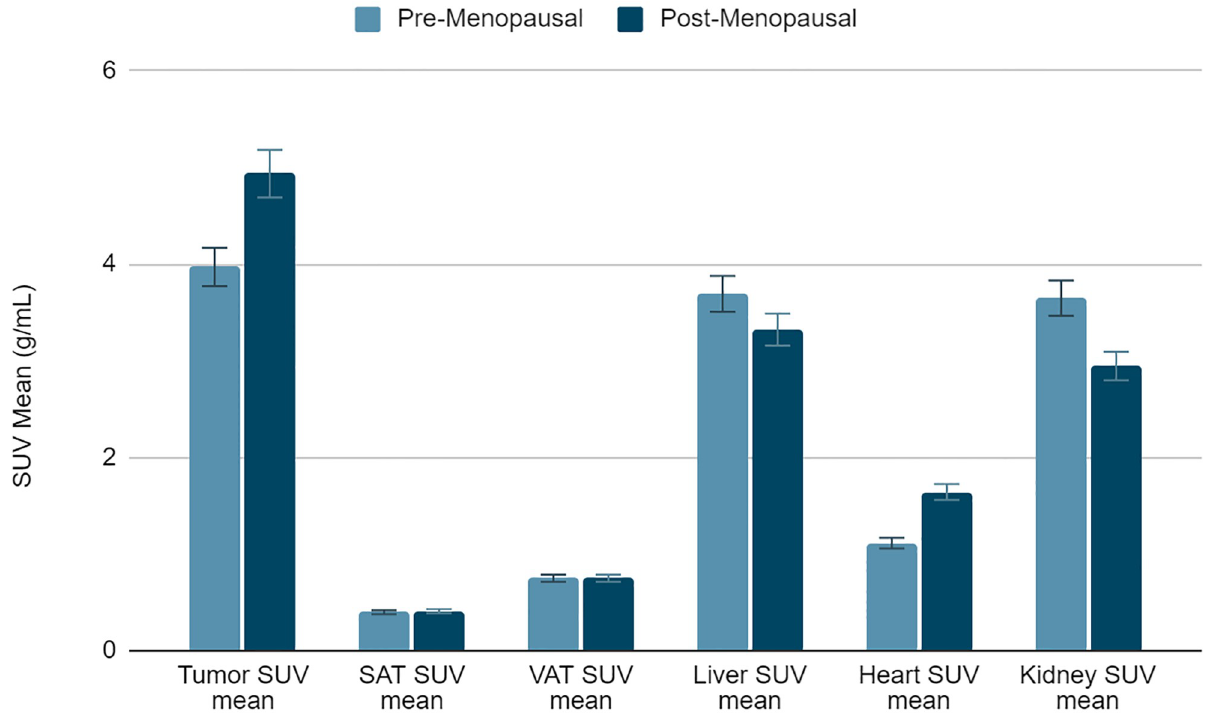
Fig 3. Lean body mass-corrected mean standardized uptake value (SUV mean ) in tumor; subcutaneous adipose tissue (SAT); visceral adipose tissue (VAT) at the level of the S2 vertebrae; liver; heart; and kidney separated by menopausal status (n = 33).